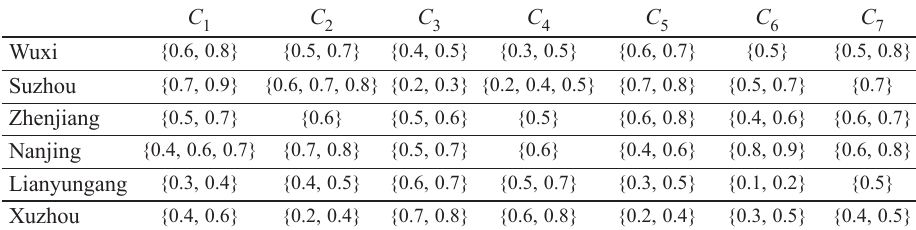
Table 1. Hesitant fuzzy decision matrix D = ( h C 1